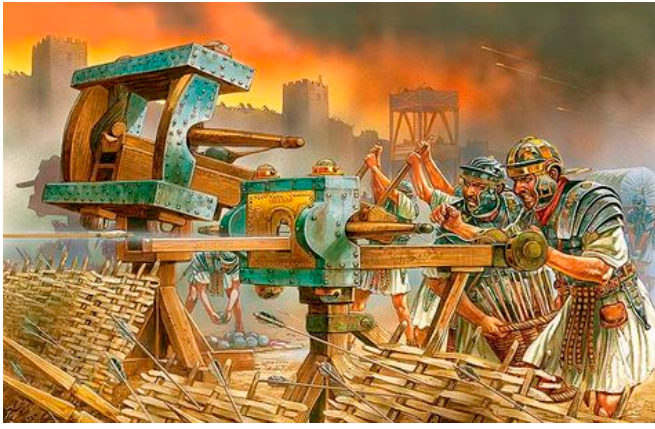
Figure 3. Ancient Roman War: setting on fire the besieged city (illustration). Source: https://www.pinterest.com/pin/426082814722448278 / .